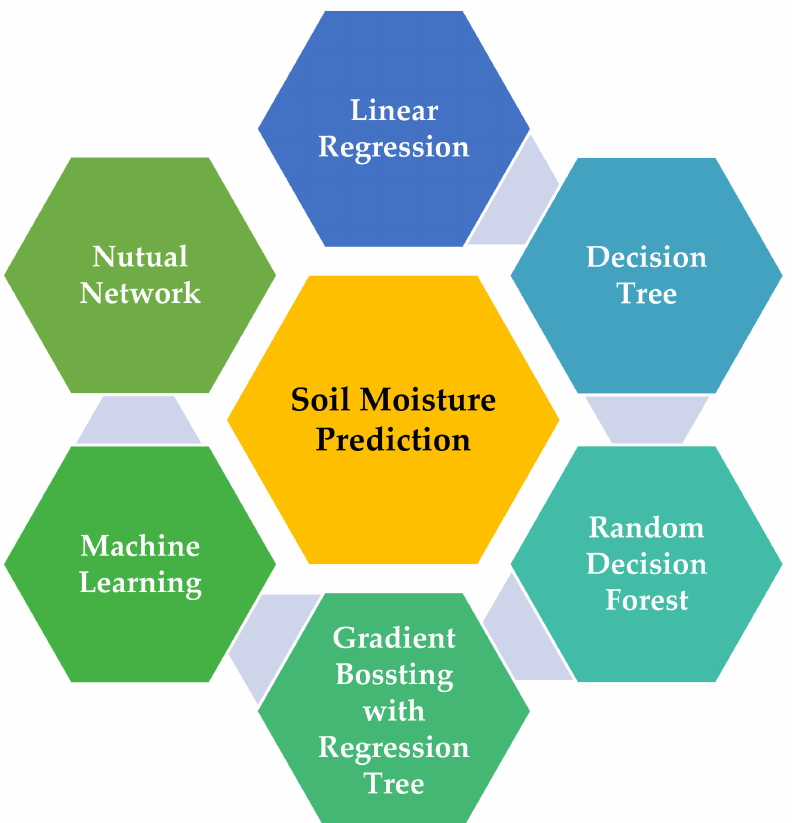
Figure 1. Commonly used methods for predicting soil moisture.